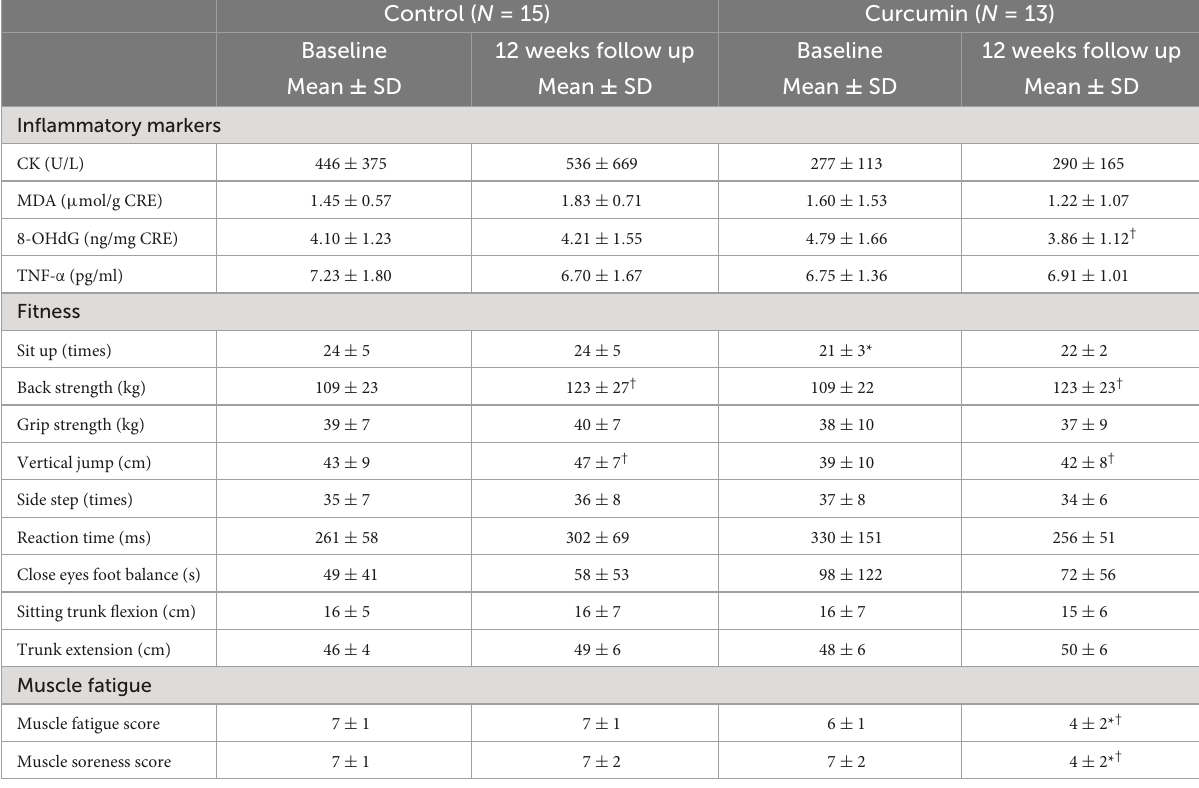
TABLE 2 Inflammatory markers, fitness, and muscle fatigue at baseline and the end of study (12